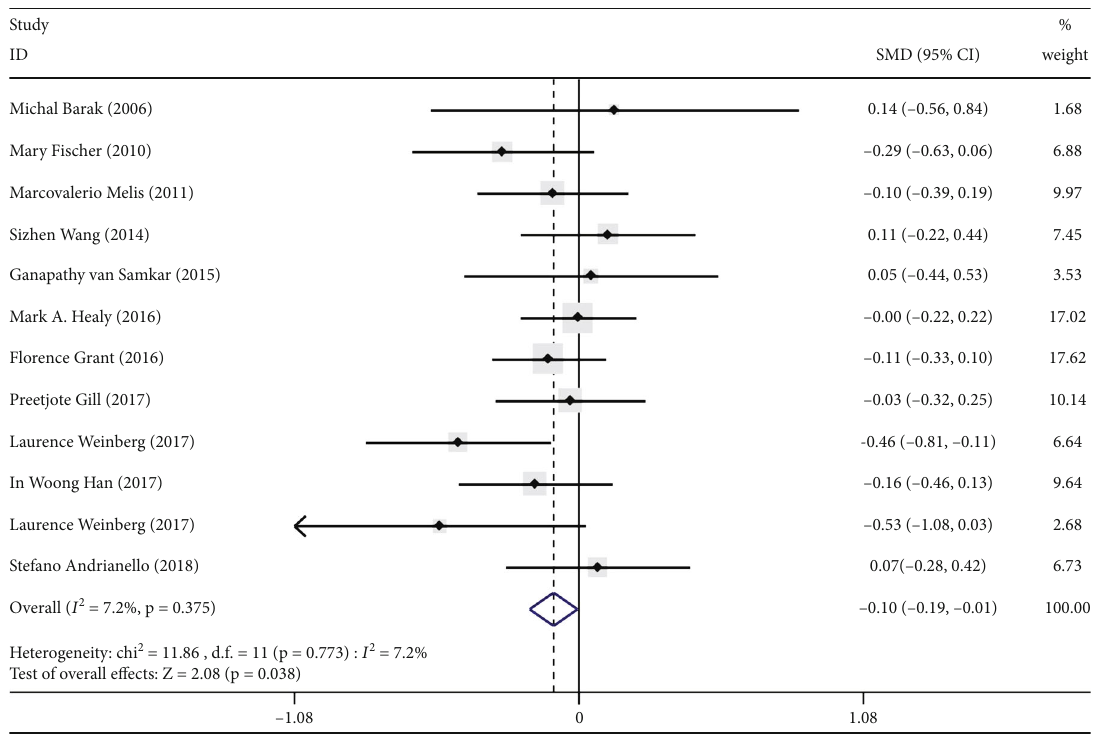
Figure 3: Forest plot for length of stay.